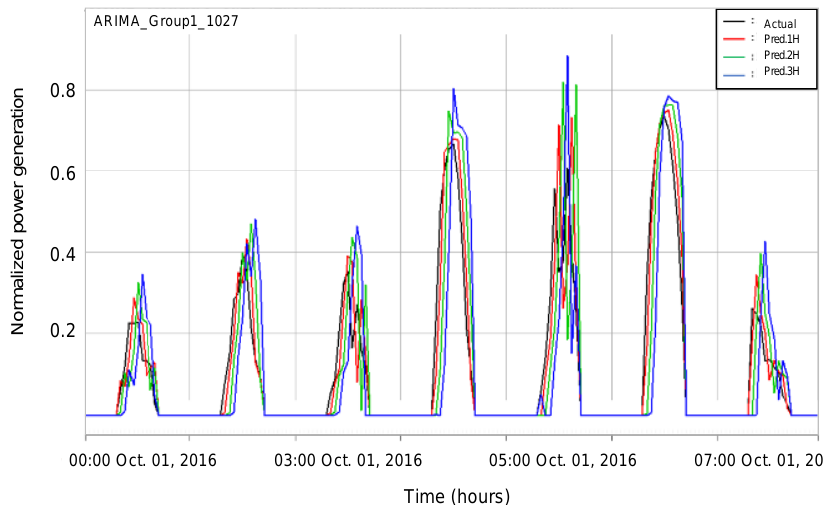
Figure 7. Time-series plot comparing values predicted using the ARIMA model from 00:00 on October 1, 2016, to 23:00 on October 7, 2016.